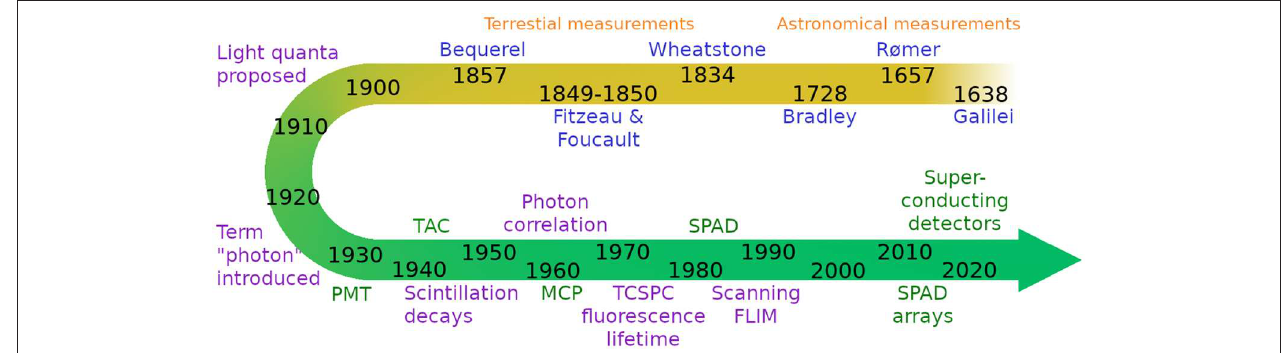
FIGURE 1 | Brief schematic timeline of single photon counting and timing technology from Galilei’s work on the speed of light to today’s photon detectors and timing electronics. Scientists are indicated in blue, ideas and concepts in purple, and technology developments in green. and can change with interaction, pH, viscosity, and other parameters